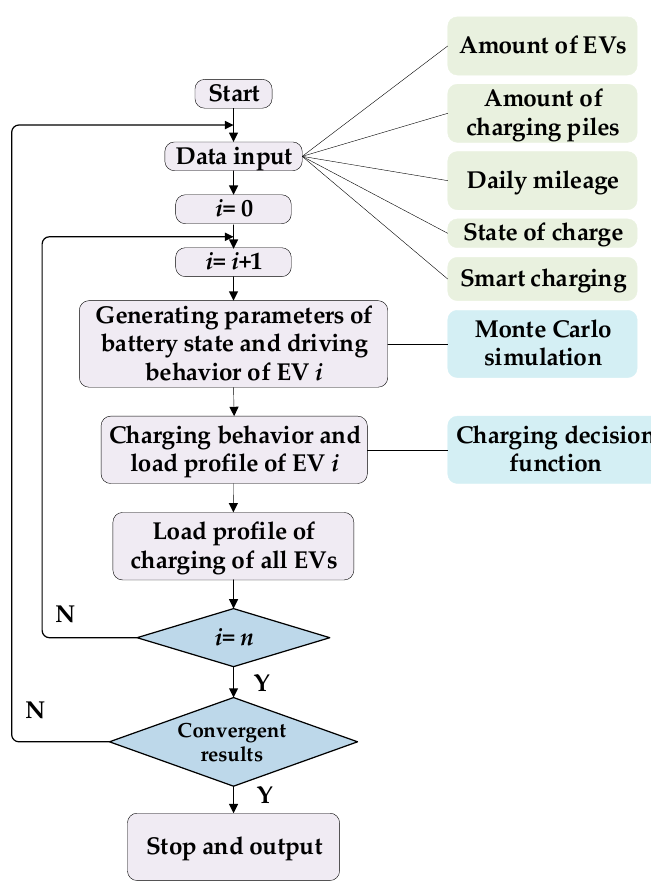
Figure 2. Flowchart of charging load profile generation.